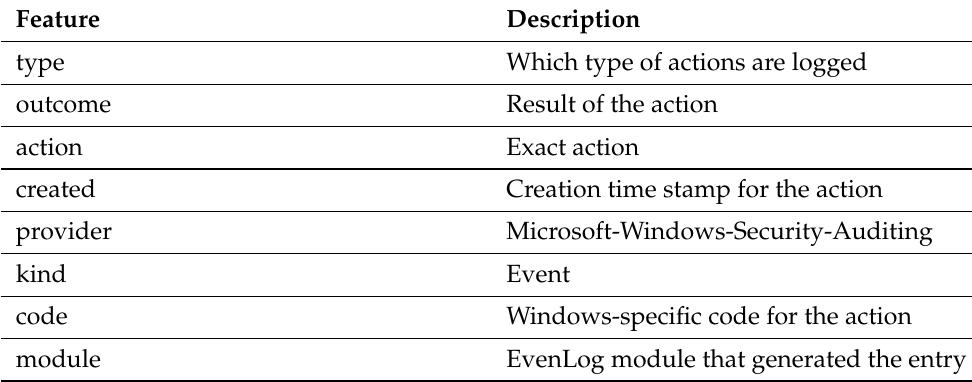
Table 6. HIDS-related attributes in CSV